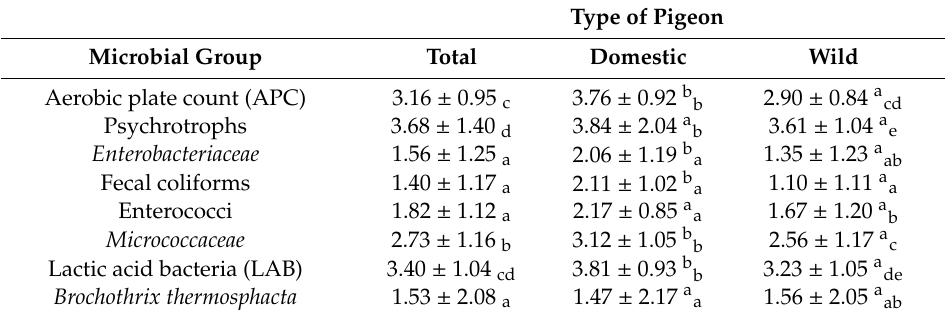
Table 2. Microbial counts (log 10 cfu / cm 2 ) on meat from domestic and wild pigeons in